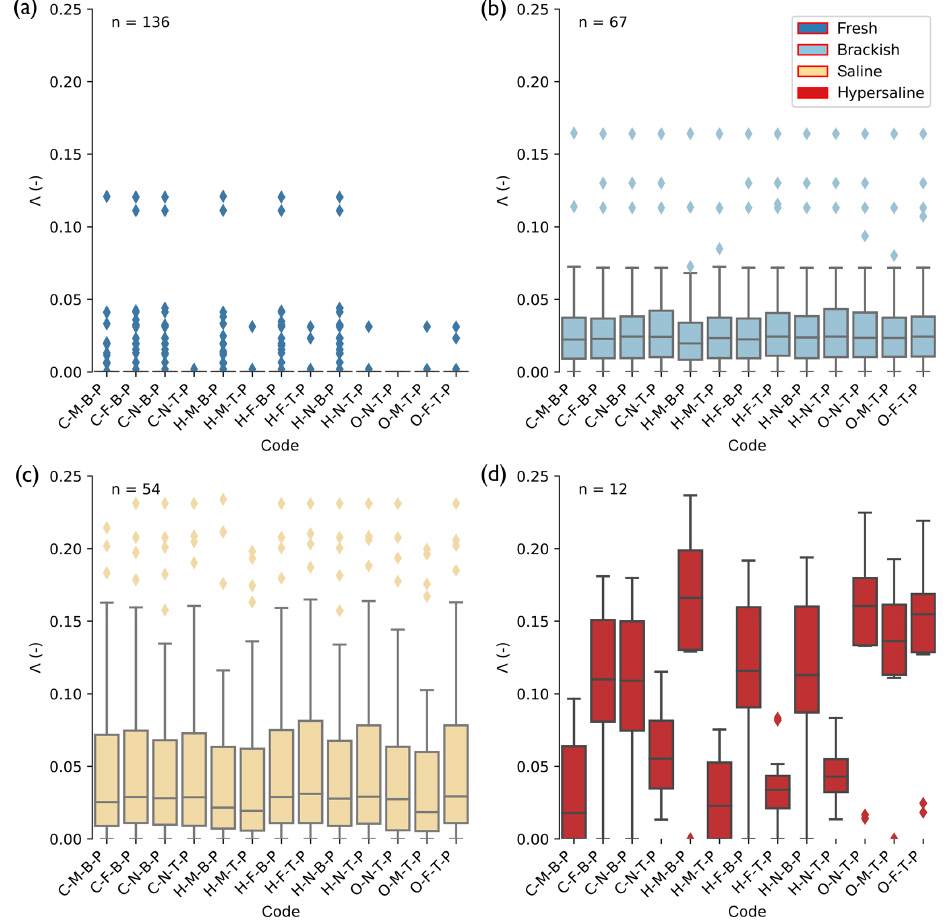
Figure 6. Goodness-of-fit boxplots for all palaeohydrogeological reconstructions, binned into four salinity classes. The higher the value of (cid:51) , the worse the fit. Codes indicate model scenarios (Table 1). TDS values are binned in the classes [0, 1], [1, 5], [5, 35], and [35, 100]gTDSL − 1 for respectively “fresh”, “brackish”, “saline”, and “hypersaline”; these are respectively plotted in panels (a) , (b) , (c) , and (d) . “ n ” indicates the amount of observations available in the TDS bin to evaluate model results with. Diamonds indicate outliers, defined as values separated from the first or third quartile at 1.5 times the interquartile range. When no box is plotted for a scenario, 75% of the measurements equal zero, which consequently causes the interquartile range to be zero, rendering every non-zero value an outlier.